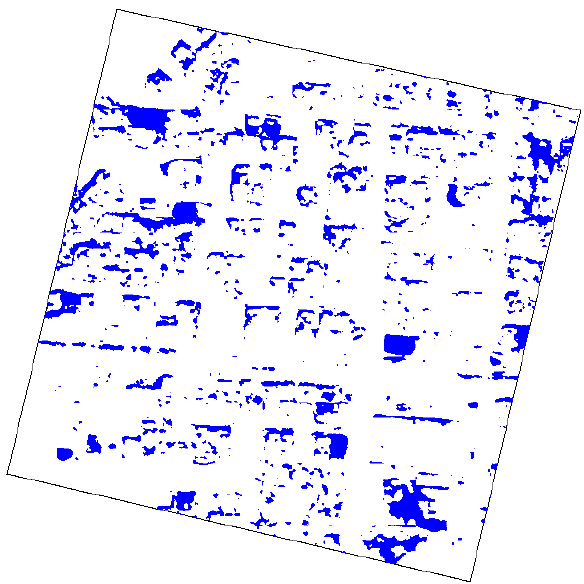
Figure 5. D-DSM of the whole area as a binary map after applying a height threshold of